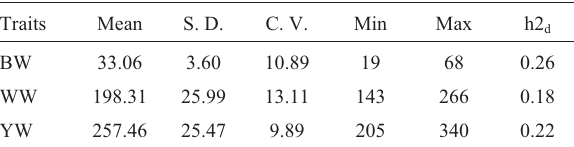
Table 1 - Descriptive statistics for growth, reproductive and ultrasound traits in the Zebu Brahman population.